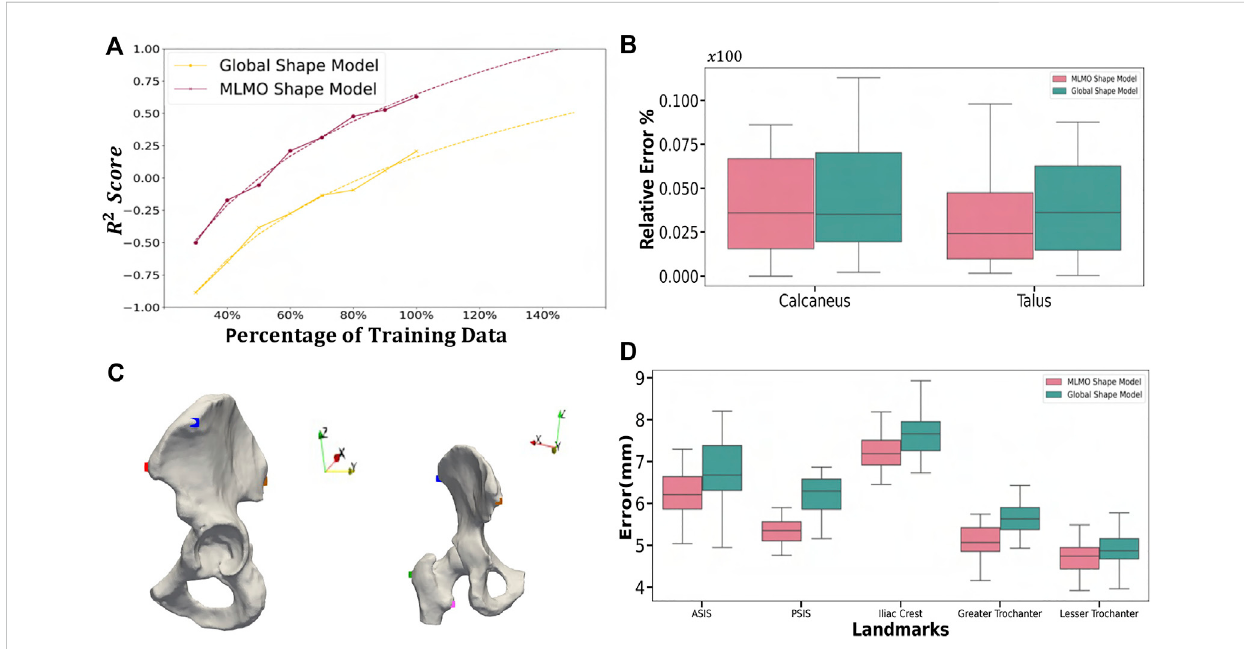
FIGURE 14 Validation Results — (A) Power law interpolation for R 2 metric computed at different training data sizes of spinal column data. (B) Box-plot for the relativeerror ofcoverage areafor calcaneus andtalus. (C) Anatomical landmarksfor femurand pelvisused forlandmarkinference -iliaccrest(blue), ASIS (red),PSIS(brown),lessertrochanter(pink)andgreatertrochanter(green). (D) Box-plotforEuclideandistanceerrorcomputedforthelandmarkinference validation task done on the hip